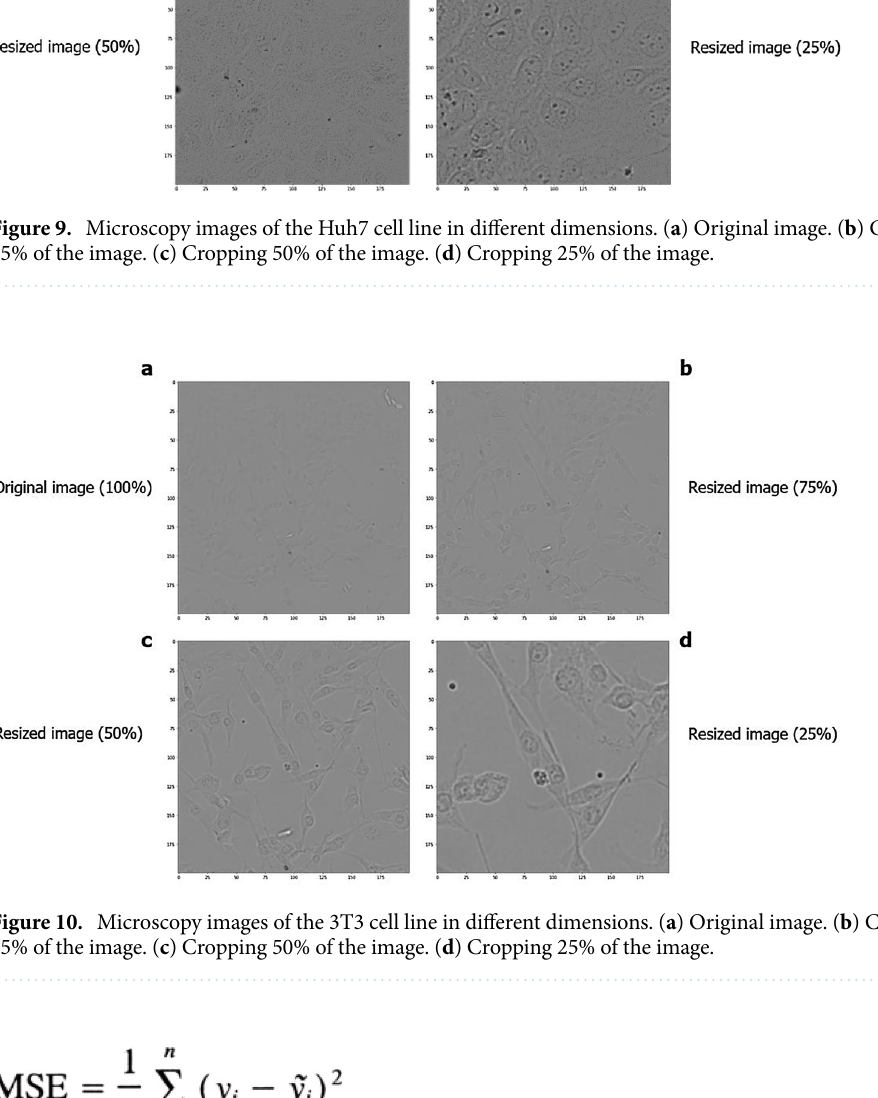
n 1 the square of (cid:31) Y i − n (cid:31) i = 1